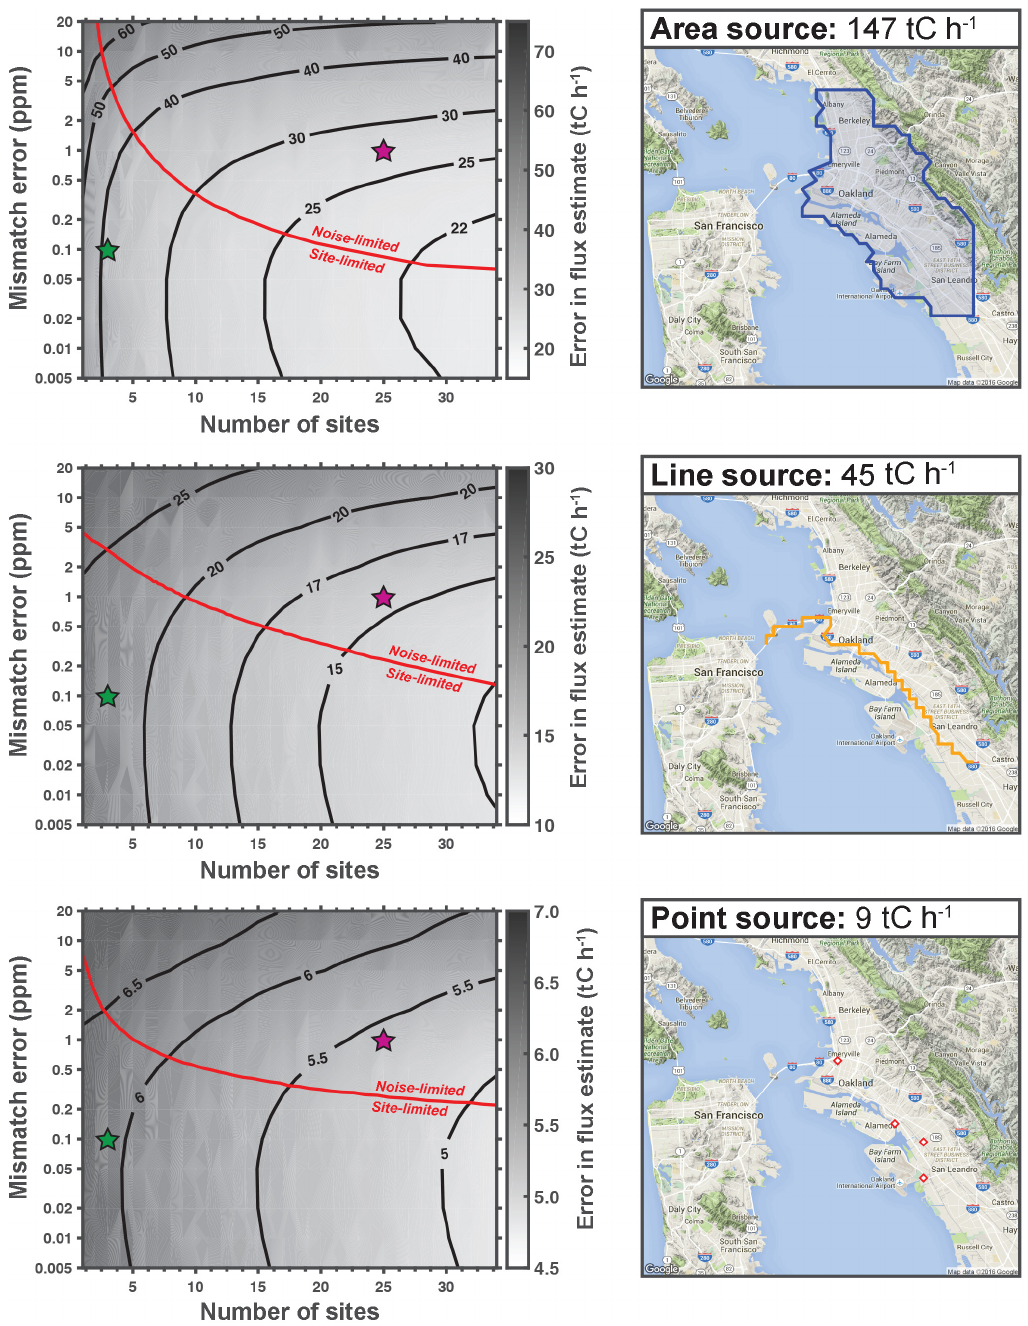
Figure 4. Left column shows the error in the posterior CO 2 fluxes. Right column shows the fluxes being estimated. Top row is the area source, middle row is the line source, and bottom row is the point source. Inversions were performed using n s = [ 1 , 2 ,..., 34 ] sites and σ m = [ 0 . 005 , 0 . 01 , 0 . 02 , 0 . 05 , 0 . 1 , 0 . 2 , 0 . 5 , 1 , 2 , 10 , 20 ] ppm mismatch error. Results shown are the mean of a Monte Carlo analysis using 20 different combinations of sites for each (n s , σ m ) pair. Contours are from the statistical models ˆ η (see Eqs. 5–7) converted to flux errors, and the red lines are the ridge lines that define the cutoff between the noise-limited and site-limited regimes. Purple star shows an observing system with 25 sites and 1ppm noise. Green star shows an observing system with three sites and 0.1ppm noise. Note the log scale on the y